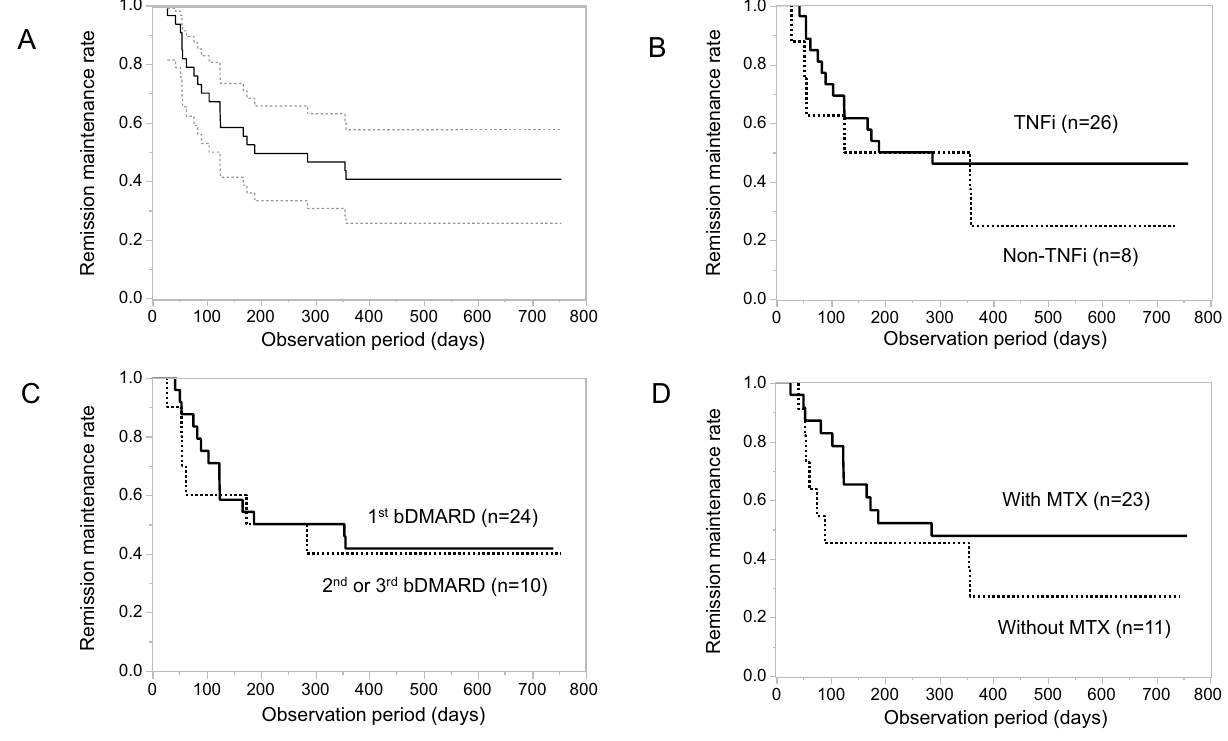
Figure 1. Remission maintenance rate and treatments. ( A ) All patients (n = 36, solid line) with 95% confidence intervals (dotted lines). ( B ) Comparison of patients discontinuing TNFi (n = 26, solid line) and non-TNFi (n = 8, dotted line). ( C ) Comparison of patients discontinuing first bDMARD (n = 24, solid line) and second or third bDMARD (n = 10, dotted line). ( D ) Comparison of patients with concomitant MTX (n = 23, solid line) and without MTX (n = 11, dotted line). TNFi tumour necrosis factor inhibitors, bDMARD biological disease- modifying antirheumatic drug, MTX methotrexate.